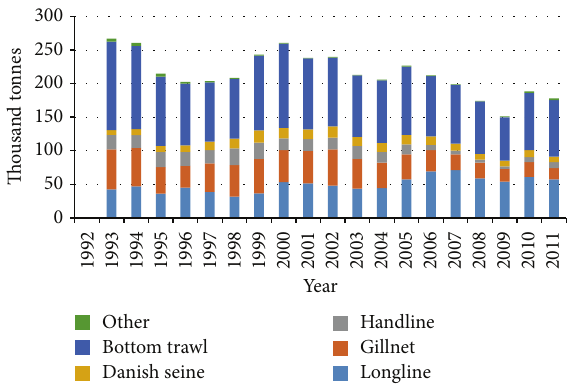
Figure 2: Total landings (thousand tonnes) of cod by fishing gear during